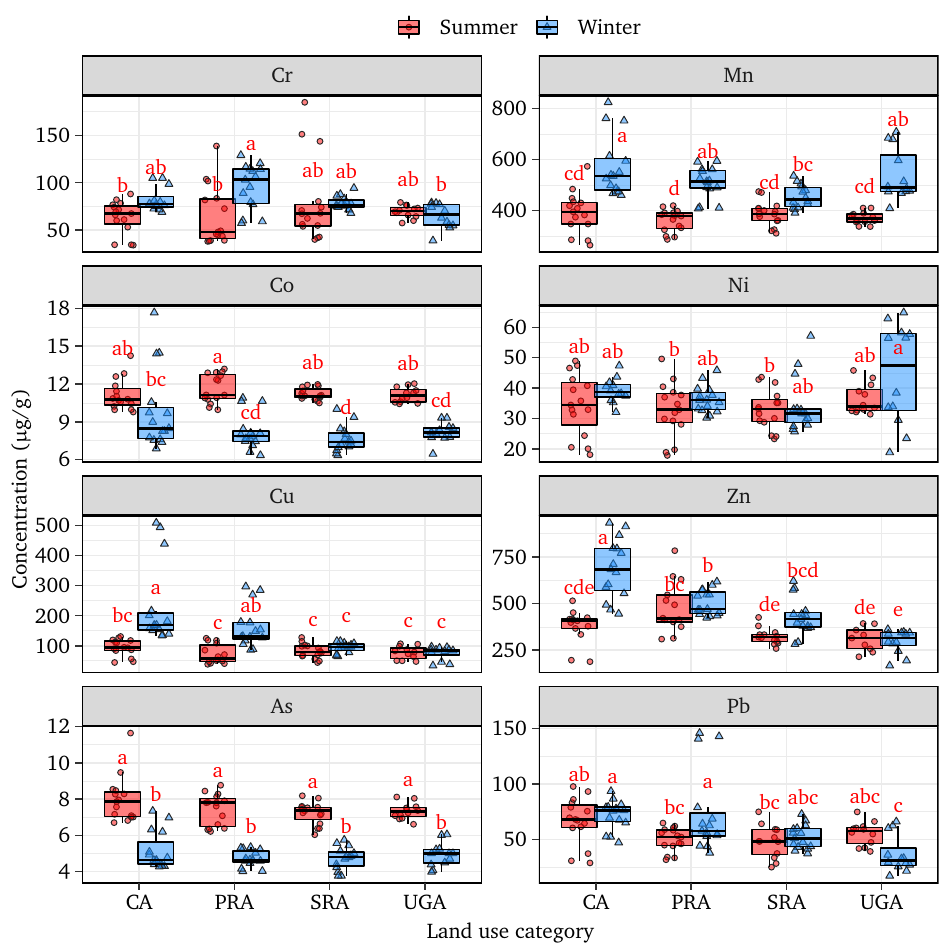
Figure 2. Concentrations ( standard error) of heavy metals in roadside dust in Dhaka city. The circles ± represent the values individual sampling points. CA = commercial area, PRA = planned residential area, SRA = spontaneous residential area, and UGA = urban green area. Bars with similar letter are not statistically significant at a 95% level of